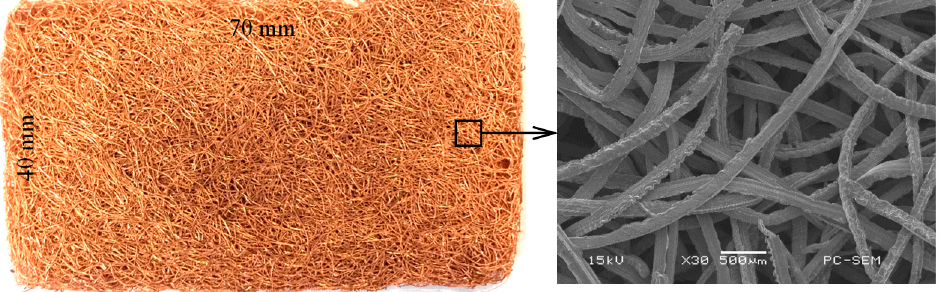
Figure 1. Photograph of 80% porosity porous metal fiber sintered sheet (PMFSS) sizing of 70 × 40 × 2 mm 3 . The SEM image on the right shows the magnified microstructure.